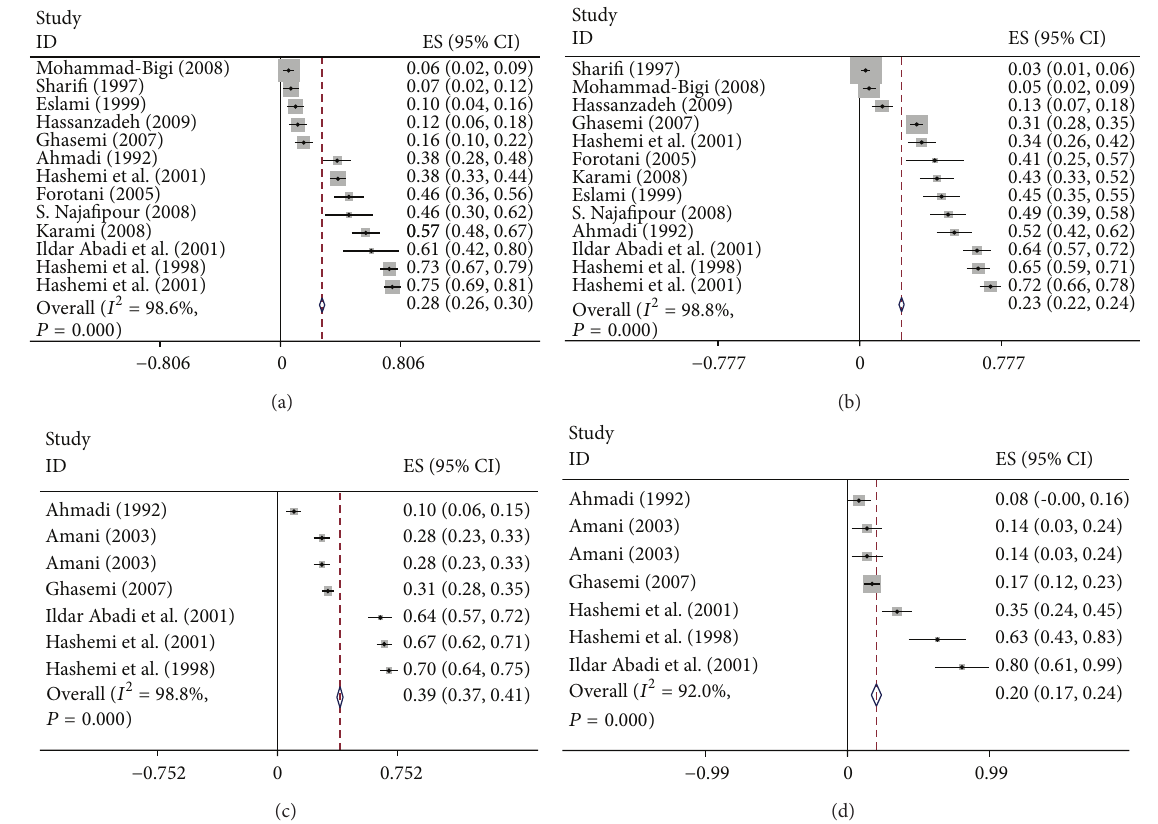
Figure3:Forestplotsofstudentdepressionforsubgroupsanalysis(forestplot(a)depressionamongmalestudents,(b)amongfemalestudents, (c) among single students, and (d) among married students).